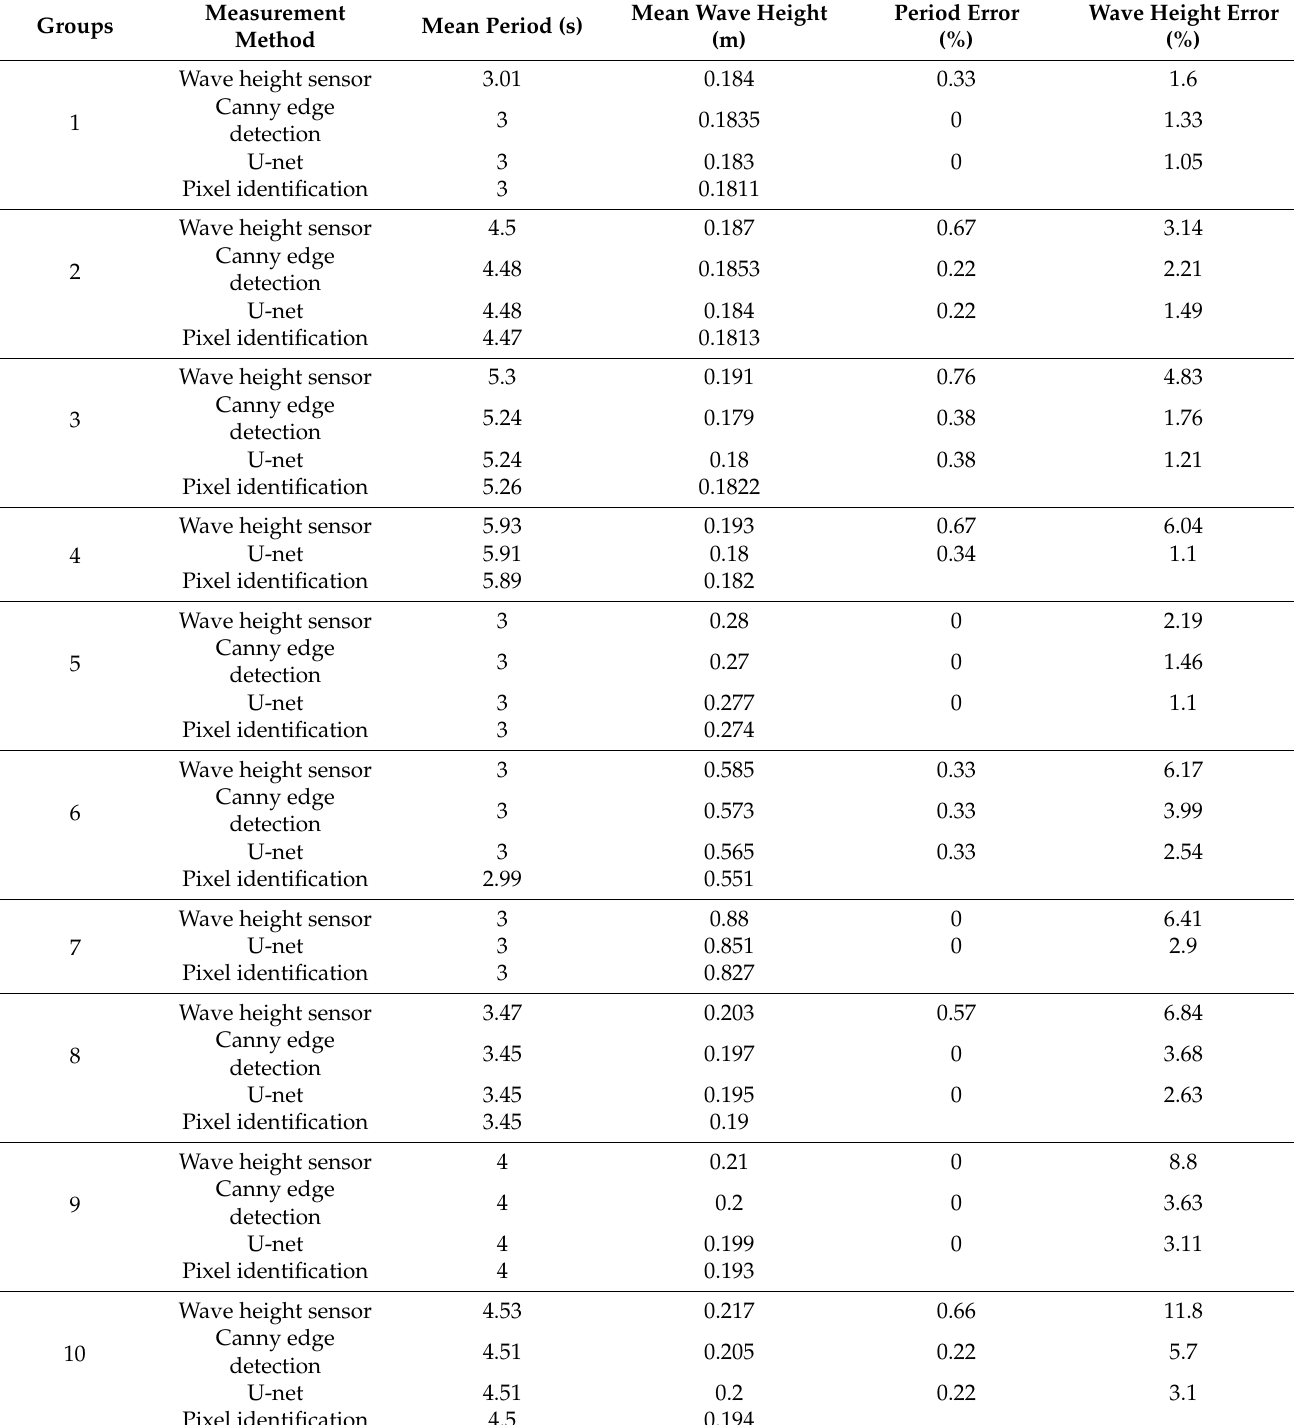
Table 3. Measurement error